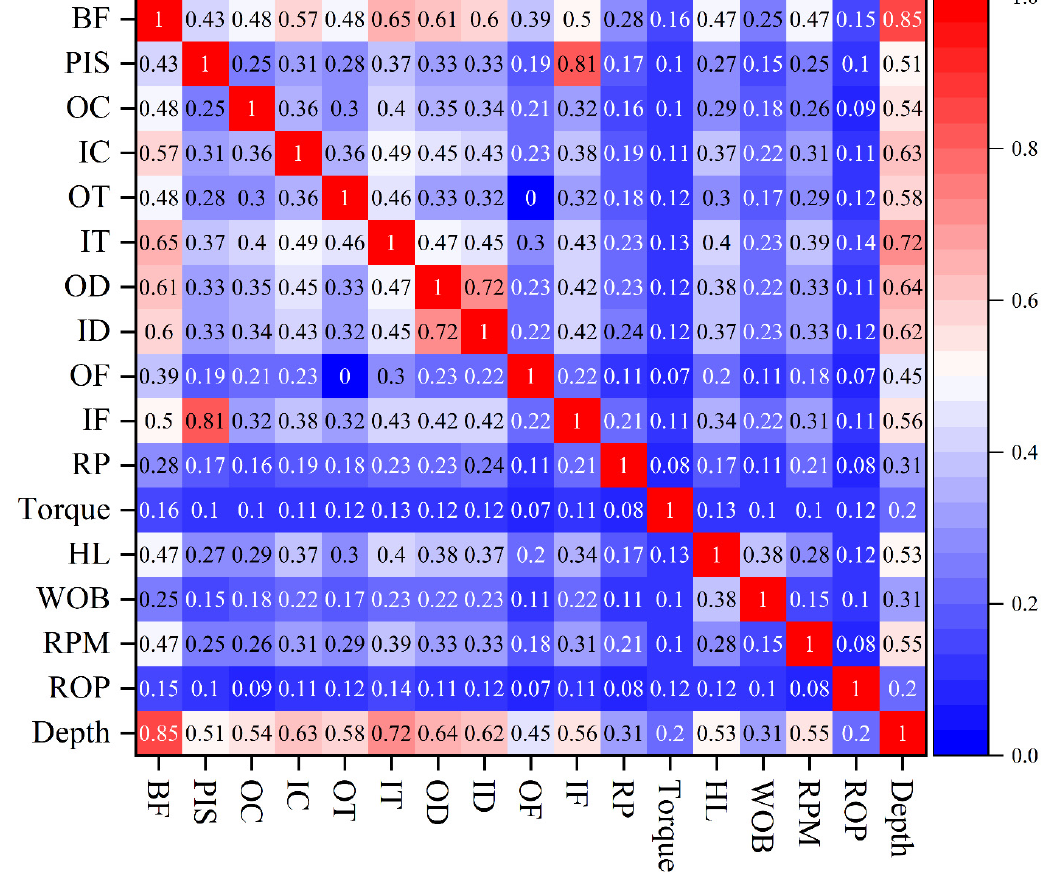
Figure 4. Mutual information correlation coefficient.